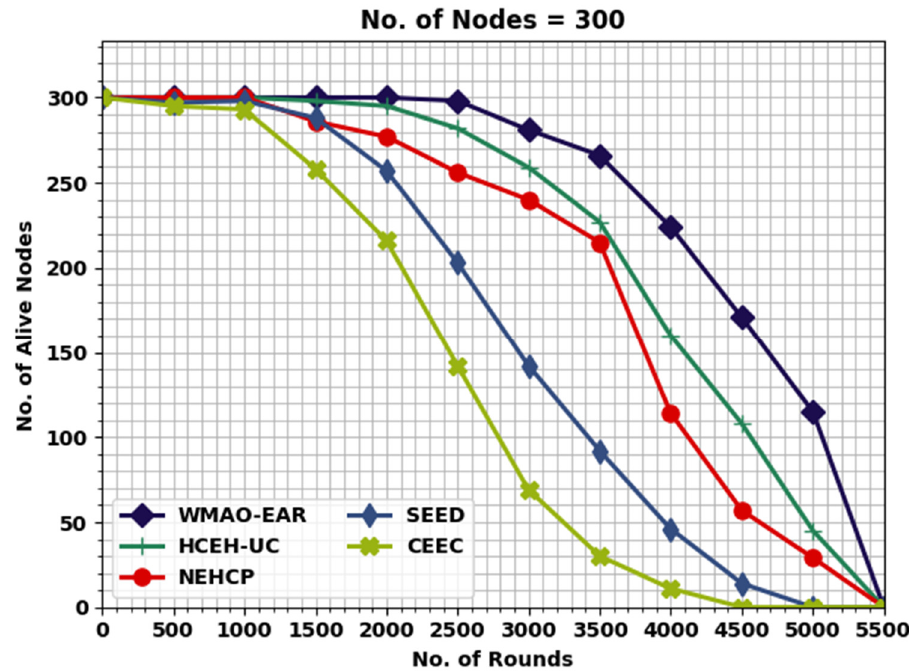
Figure 8. NOAN analysis of WMAO-EAR approach under NC of 300.